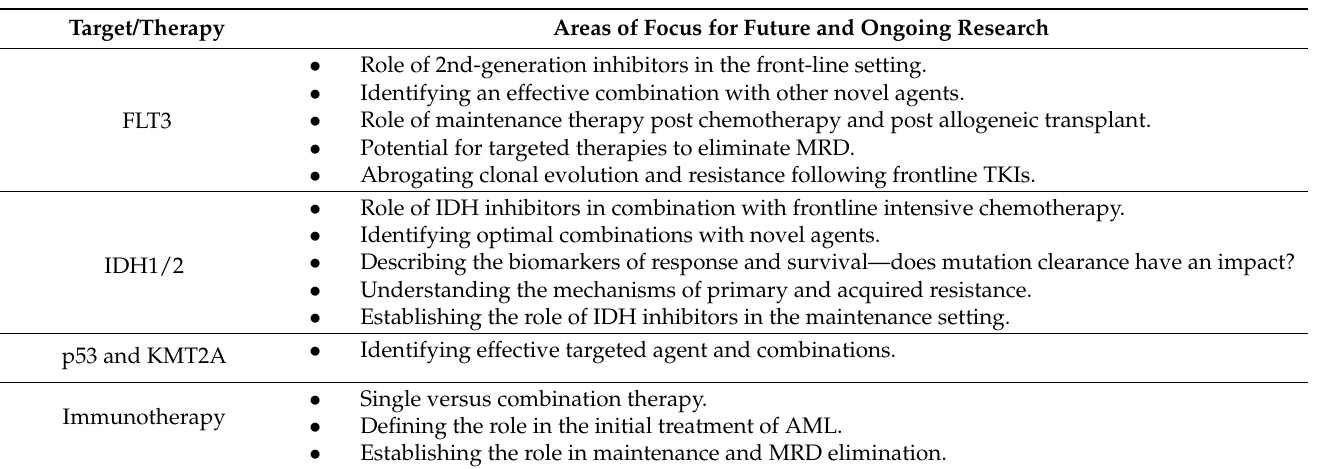
Table 2. Potential areas for future